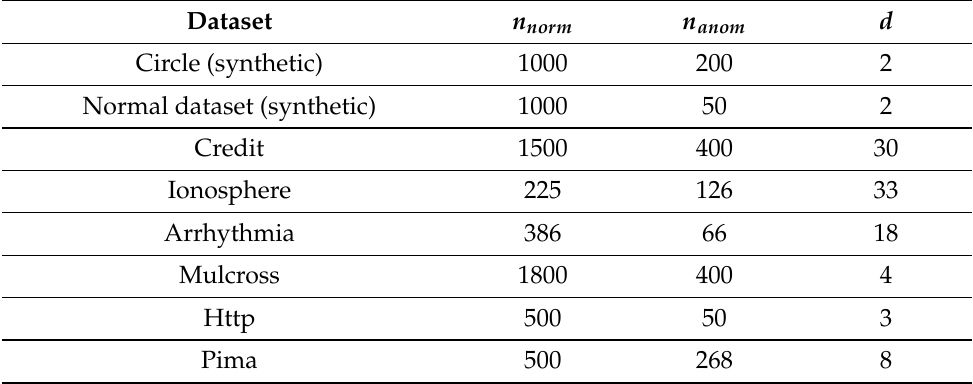
Table 1. A brief introduction to the datasets.